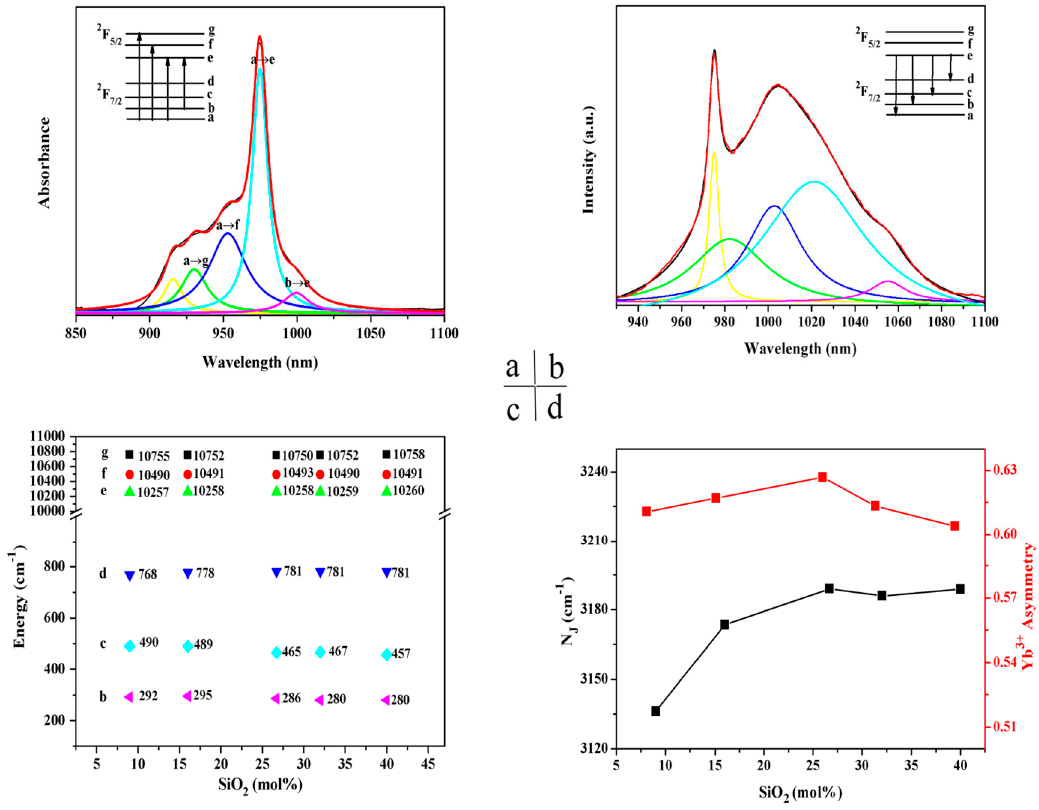
Figure 3. Lorentz peak analysis for absorption ( a ) and emission ( b ) spectra of 20BaO-53.3P 2 O 5 -26.7SiO 2 -1Yb 2 O 3 glass (the black lines are the original spectra, while the red lines offer the fitting lines composed of the corresponding multi-fitting peaks); ( c ) Stark level energies of 2 F 7/2 and 2 F 5/2 manifolds in 20BaO- (80- x )P 2 O 5 - x SiO 2 -1Yb 2 O 3 ( x = 9, 16, 26.7, 32, and 40 mol %, respectively) glasses obtained from the Lorentz fitting to the absorption and emission spectra; ( d ) Scalar crystal-field parameters N J and Yb 3+ asymmetry degree in 20BaO-(80- x )P 2 O 5 - x SiO 2 -1Yb 2 O 3 ( x = 9, 16, 26.7, 32, and 40 mol %, respectively) glasses.